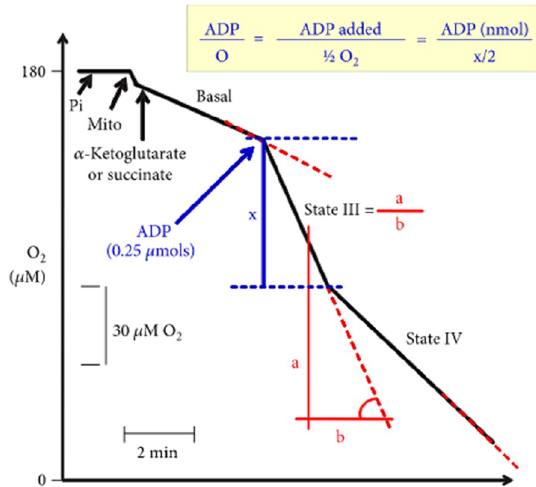
Figure 1. Experimental protocol and calculation